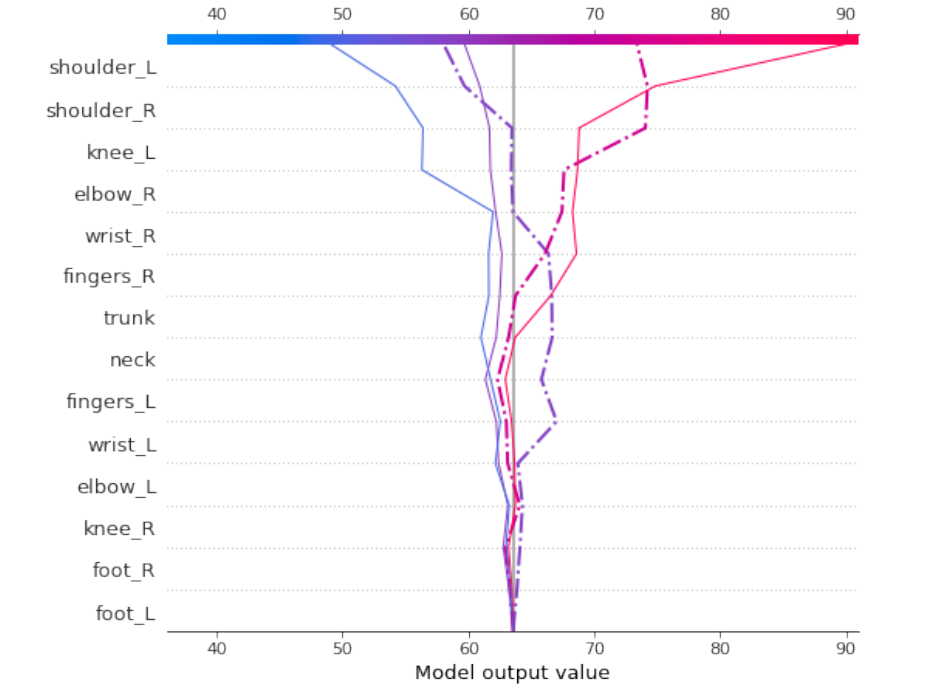
Figure 9. Decision plot for 5 sample records in which the prediction made by the model for each particular observation is